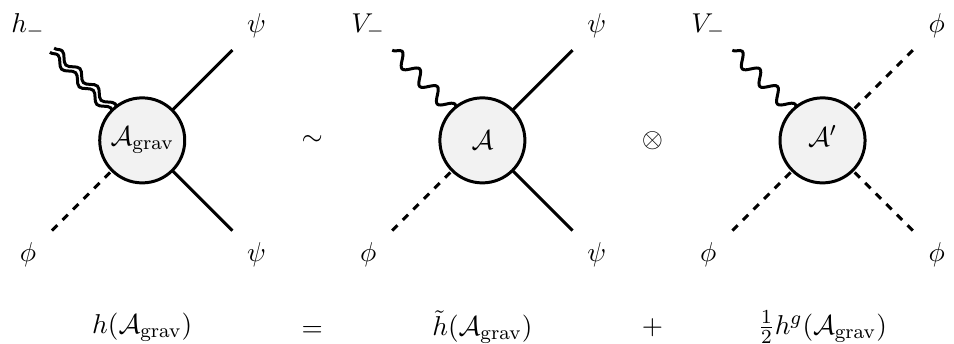
Figure 2 . Interpretation of the modified helicity bounds for the A ( h − , ψ, ψ, φ ) amplitude in terms of double copy relations. The modified helicity treats the graviton as a helicity-one particle and preserves the helicity of | h | ≤ 1 matter. Thus splitting the helicity as h = ˜ h + 1 factorization of the amplitude into a helicity ˜ h gauge amplitude A including all matter particles and a helicity 1 h g gauge amplitude A 0 with the matter particles replaced by scalars. The modified 2 helicity bound | ˜ h | ≤ n − 4 corresponds in this picture to the helicity bound for marginal theories applied to A